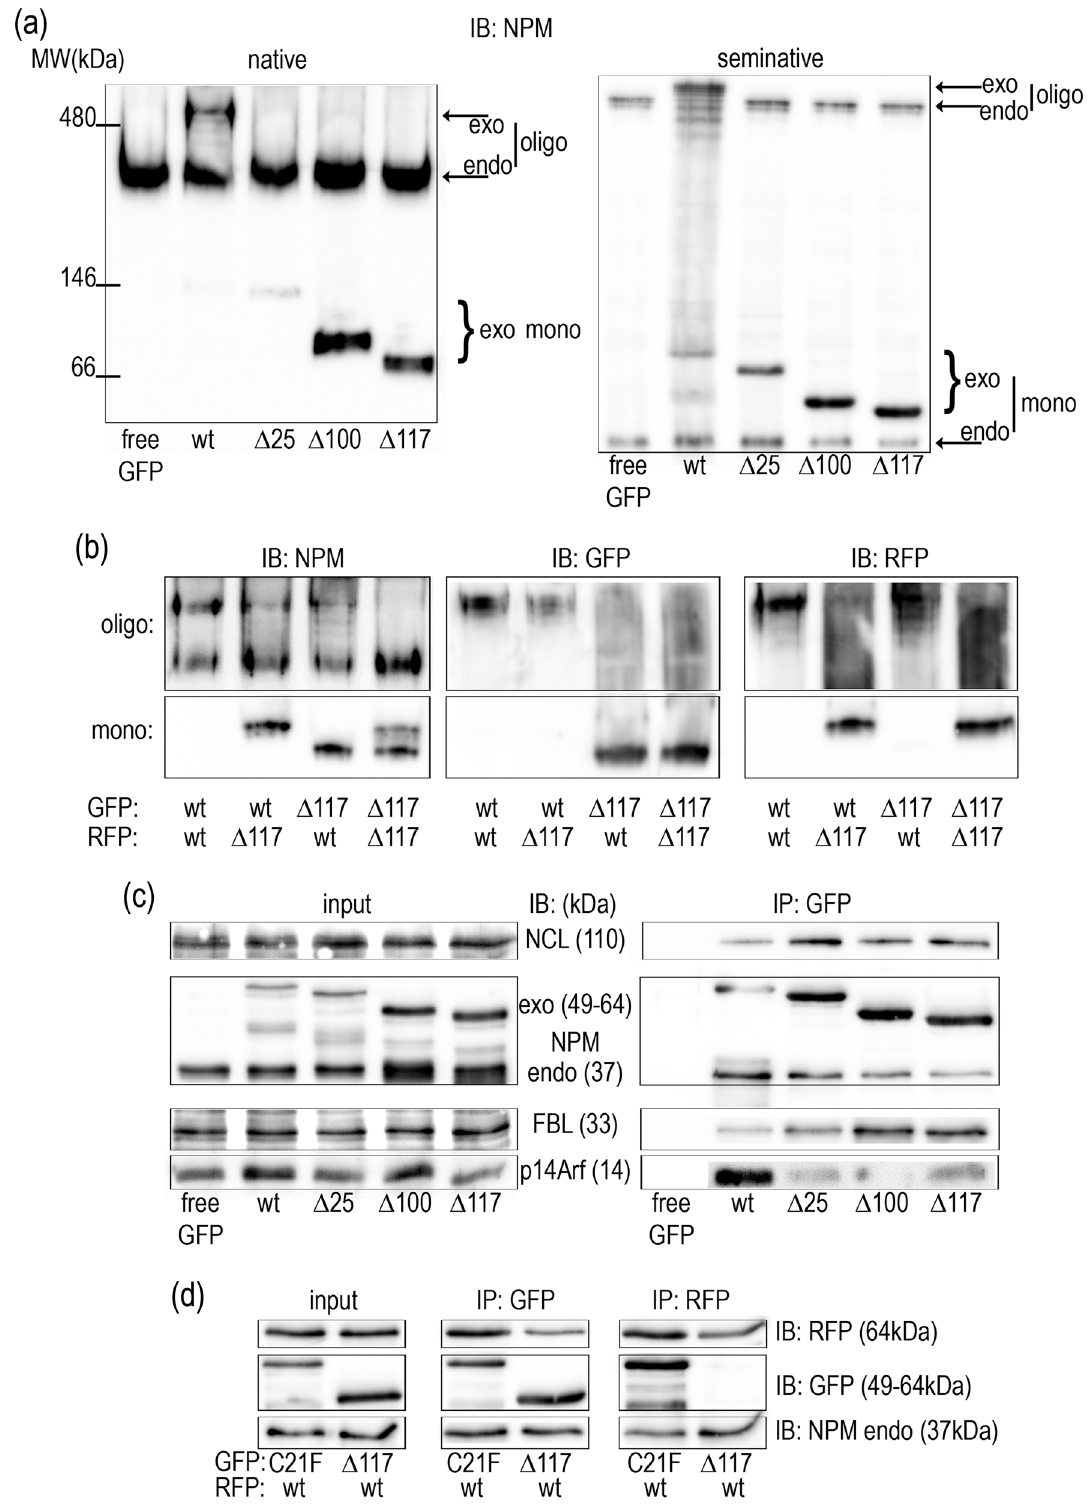
Figure 5. Significance of the N-terminus for NPM oligomerization. ( a ) NPM expression in native and semi- native PAGE of 293T cells transfected with free eGFP and eGFP-tagged truncated NPM variants. ( b ) Native PAGE of 293T cells co-transfected with combinations of Δ117 and NPMwt illustrating absence of interaction between Δ117 and NPMwt. ( c ) Interaction of truncated NPM forms with endogenous proteins. Lysates from 293T cells expressing GFP-labeled NPMwt, Δ25, Δ100 and Δ117 were subjected to immunoprecipitation and the levels of co-precipitated interaction partners were investigated. ( d ) eGFP/mRFP1-immunoprecipitation from 293T cells co-transfected with R_NPMwt and G_C21F or G_Δ117: asymmetric results of precipitation from the sample containing the truncated NPM